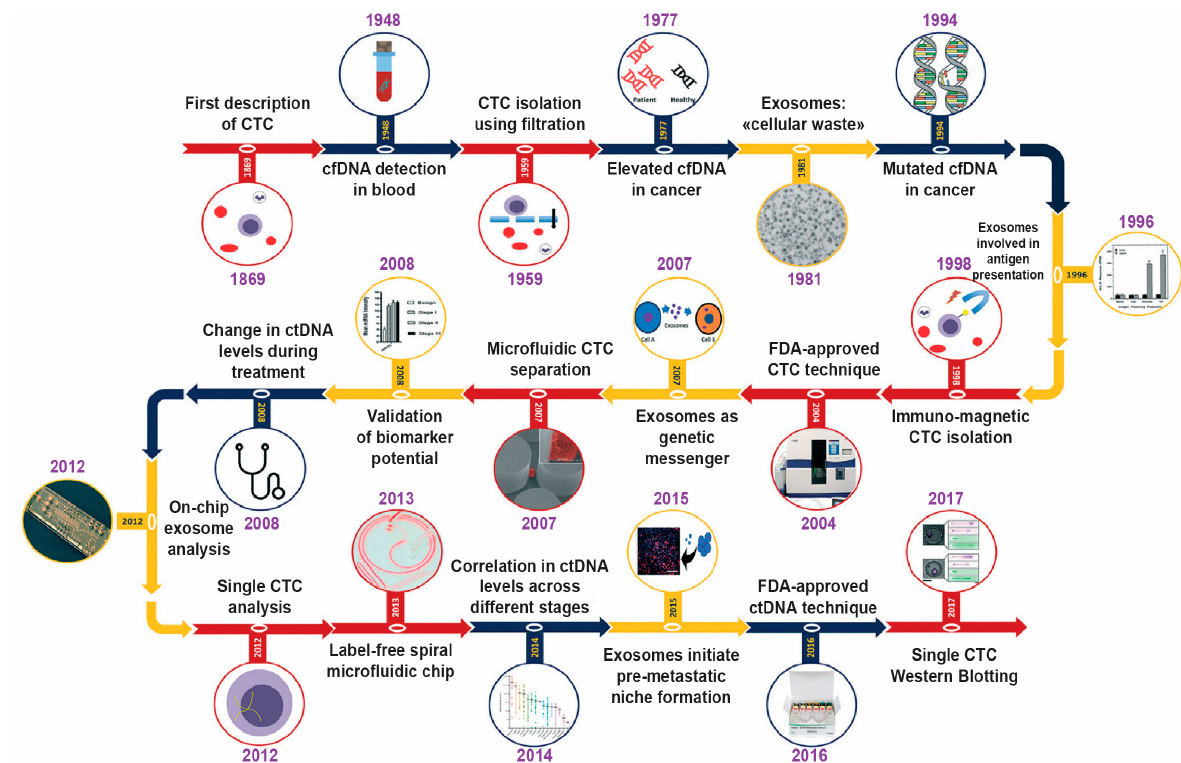
Figure 1. Historical progress of the liquid biopsy research development. The scheme highlights the major milestones in liquid biopsy research, such as EVs, ctDNA, and CTCs. Reused with permission from Ref. [8] ©2019 Royal Society of Chemistry.